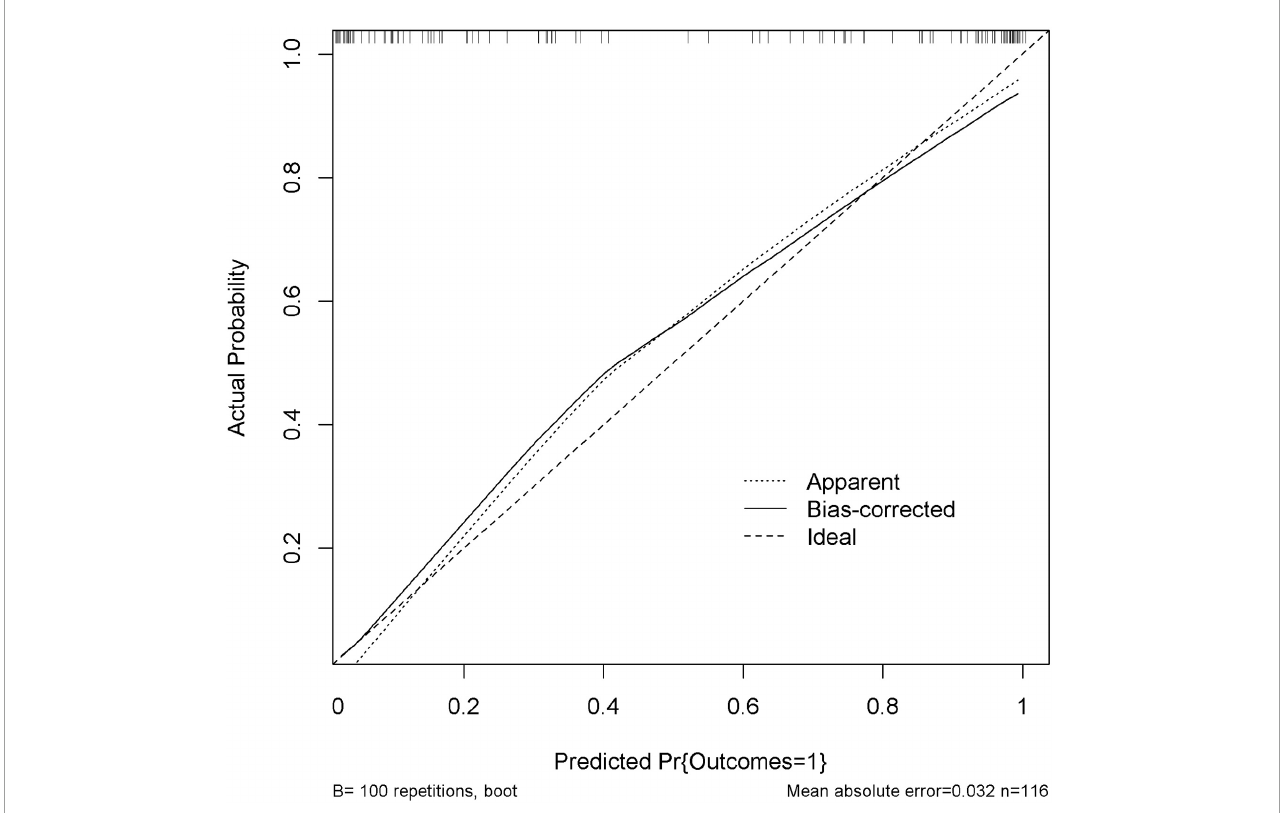
FIGURE5 Calibration curve of the nomogram. Internal validation was performed using the 100 bootstrap resampling method. The predicted probability and the actual probability are presented by the X and Y axes, respectively.